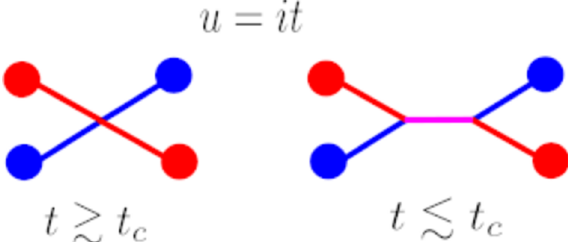
Figure 10 . Crossing a wall of marginal stability in the SU(2) theory. Right: weakly coupled cham- ber where the W-boson is BPS and realized via a string junction system ending on the defects. Left: strongly coupled chamber where the W-boson has decayed into a two-particle state corresponding to the two BPS dyons with electric-magnetic charges (2 , − 1) and (0 , 1)